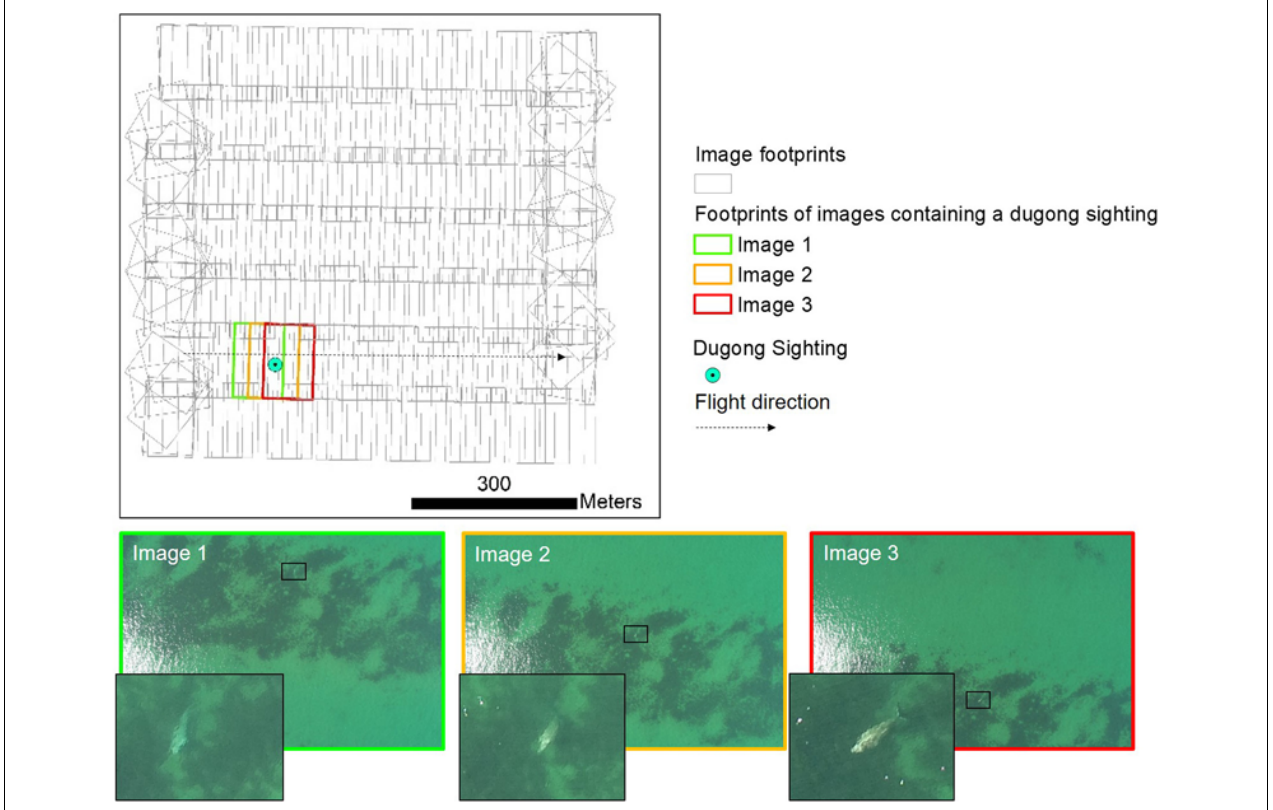
FIGURE 2 | Example of a series of three consecutive images taken at 3 s intervals along a transect line. Each image contains the same individual dugong but its identification becomes certain only in the third